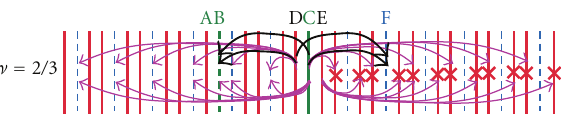
Figure 18: Coulomb transitions of nearest hole pair at ν = 5 / 13.